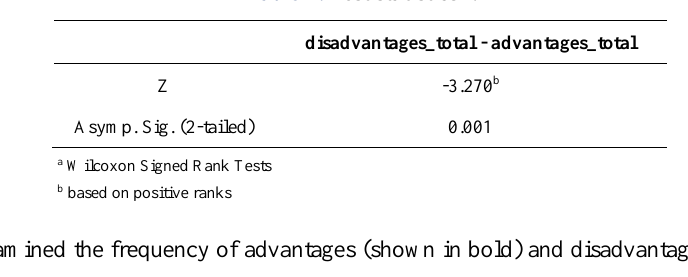
Table 4. Test statistics a .